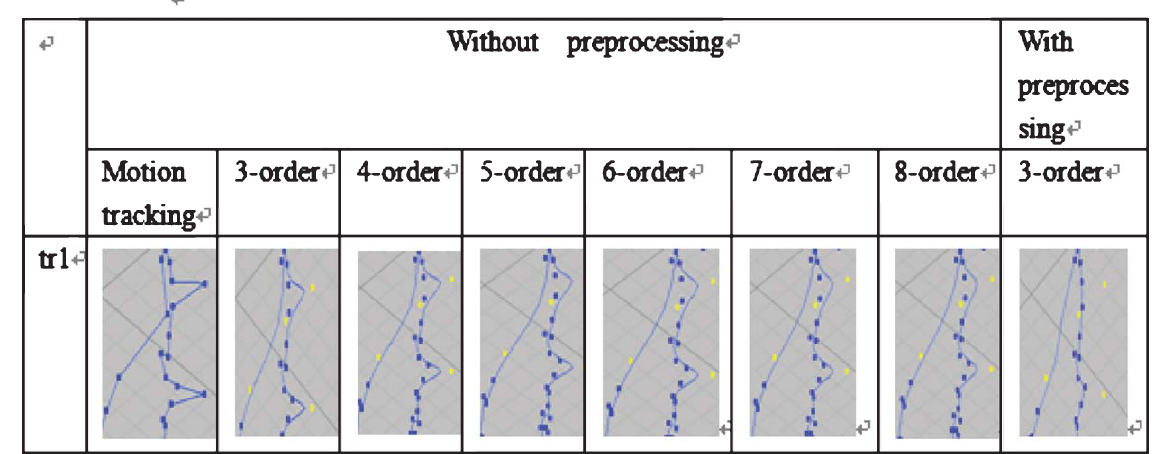
Fig. 8. Trajectories produced using two points with different